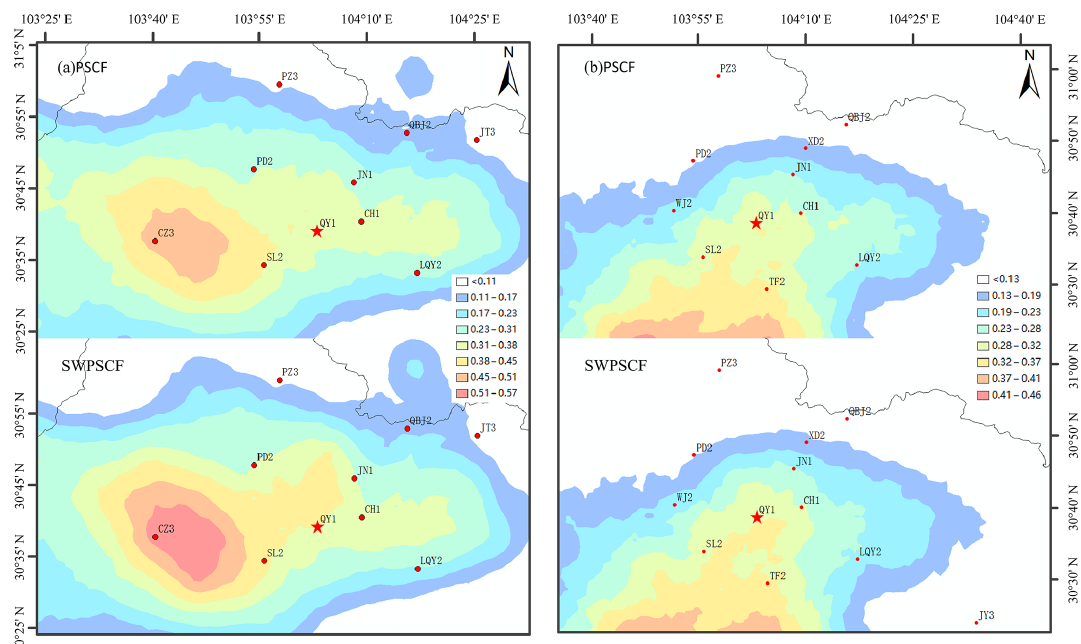
Figure 8. Potential source locations identified by the PSCF and SWPSCF methods: (a) coal and biomass combustion source in 2015; (b) traffic emission source in